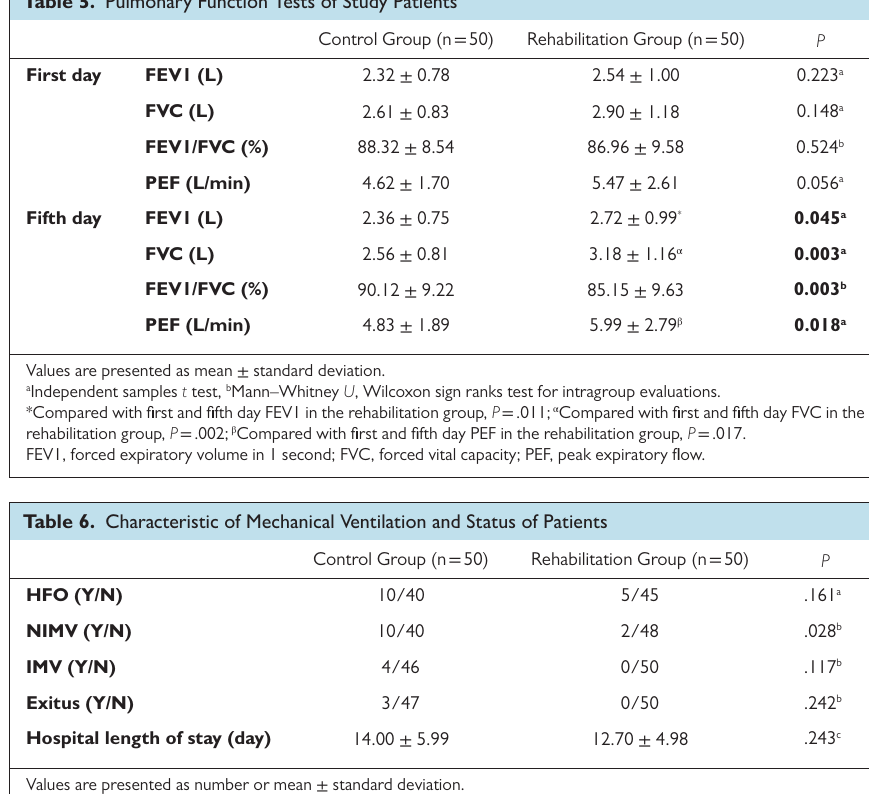
Table 5. Pulmonary Function Tests of Study Patients